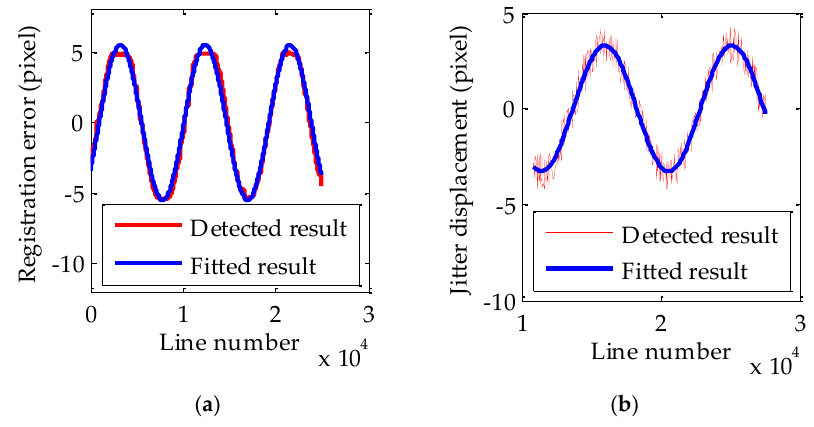
Figure 8. ( a ) The relative registration error curve between CCD1 and CCD2; ( b ) The absolute registration error curve of CCD1. Table 7. Fitting residuals of registration error curves.